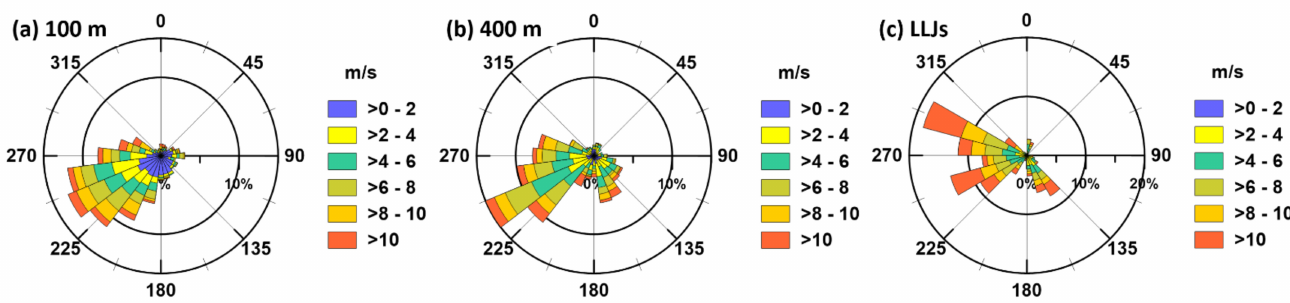
Figure 7. Wind rose for the wind at 100 m ( a ), at 400 m ( b ) and ( c ) for LLJs at the height of the wind maximum from SODAR data during the investigation period (15 ◦